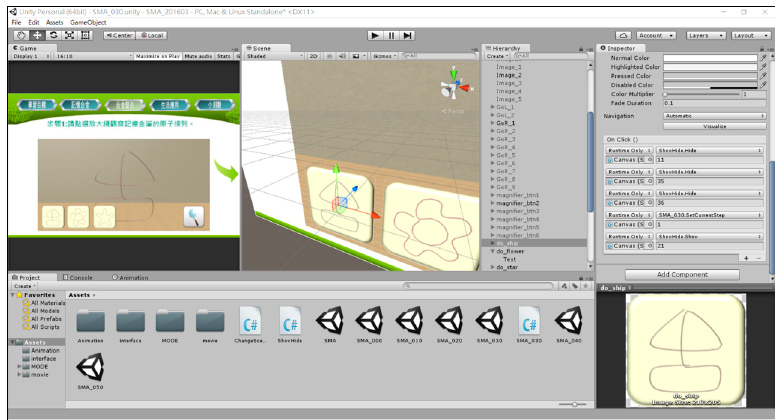
Figure 5. Using Unity3D to design the user interface in the virtual experiment.